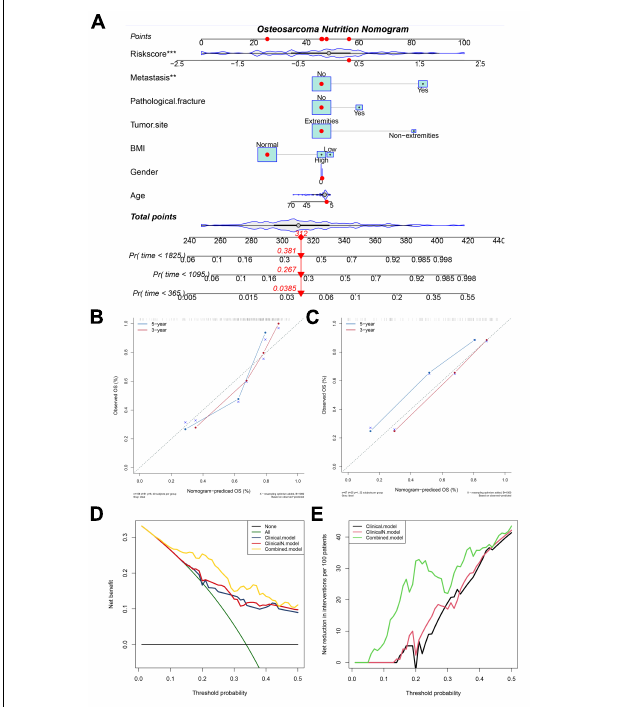
FIGURE 4 | NMRS-based nomograms have good predictive ability and predictive stability. (A) NMRS-based nomogram, in which NMRS with tumor metastasis status is the two most important factors; (B,C) Calibration curve of NMRS nomogram for predicting 3-year vs. 5-year overall survival in patients with osteosarcoma (training set and validation set); (D) Decision curve analysis of the NMRS nomogram, which only complements BMI to clinical features yielded little clinical net benefit (clincalN). When NMRS is introduced into clinical features it yields definite clinical net benefit (Combined); (E)